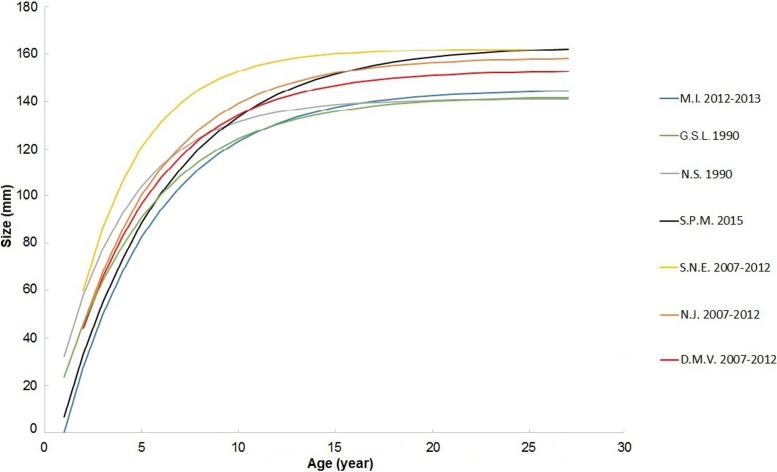
sVBGF curves in the last study from each geographic zone (details in Table 1).